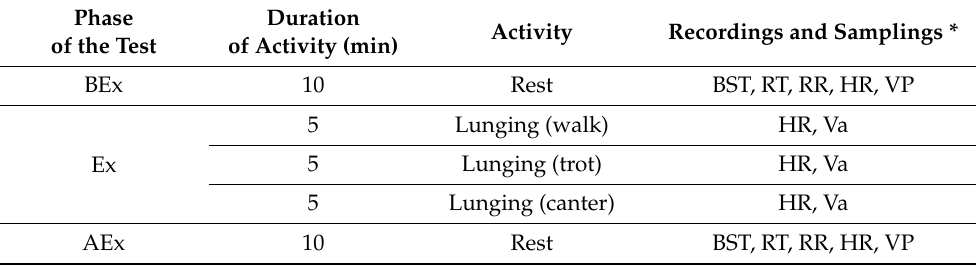
Table 1. Phases of each exercise test (duration of activity, its type, recordings, and samplings are given for each phase of the